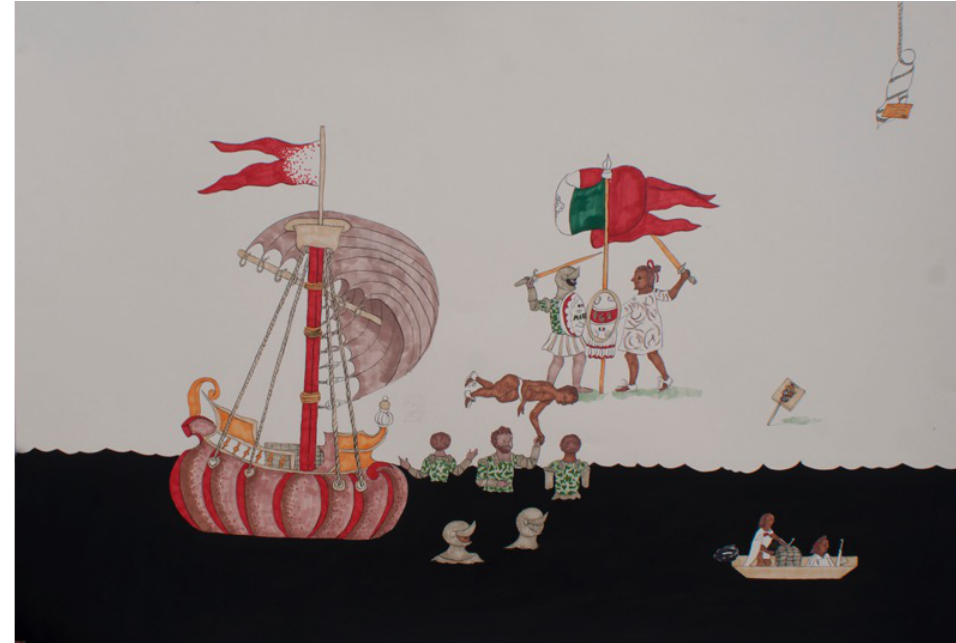
Gabriel Garcilazo, Dystopic Magical Codex: Codex 11 (The Arrival to Mexico) , 2015. Charcoal and ink on paper. Diptych 70 x 100 cm. Private collection. Image courtesy of the